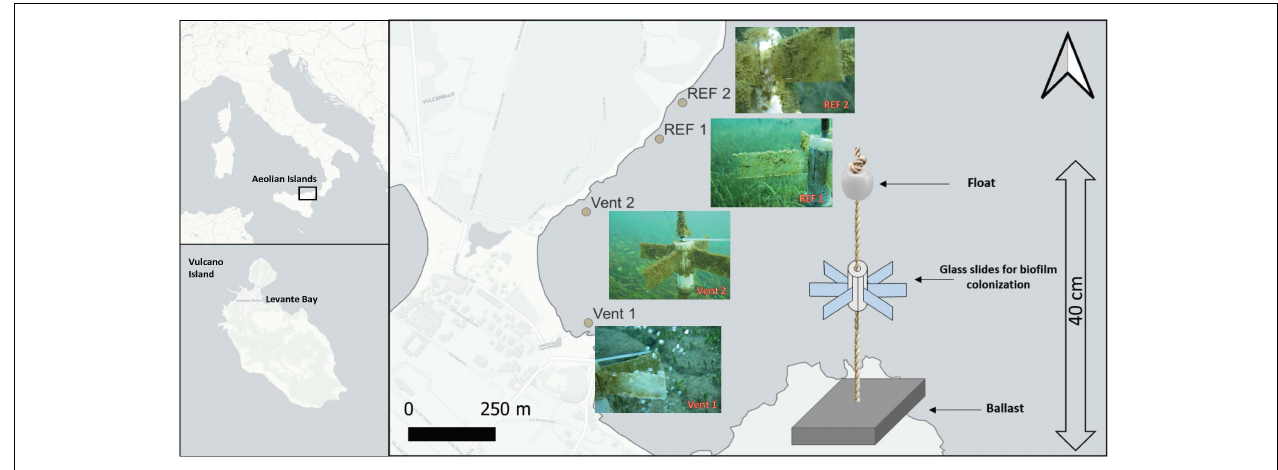
FIGURE 1 | Map showing the location of the study site (Vulcano Island-Levante Bay) and the four sites chosen for the experiments. (Right) scheme of the satellite-like structure used for the experiment. (Left) pictures of the biofilms collected from the different sites at the end of the experiment.